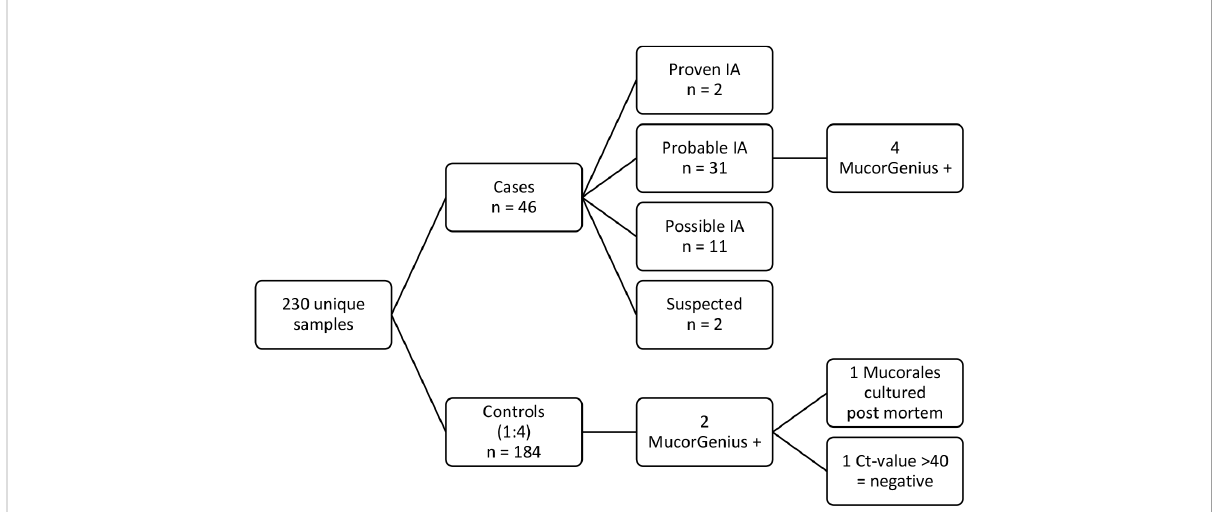
FIGURE 1 Overview of samples tested with Mucorales PCR. Cases were de fi ned based the 2020 EORTC/MSGERC consensus criteria (Donnelly et al., 2020). Controls were patients that underwent a diagnostic workup but never received anti-Aspergillus therapy due to lack of supportive evidence. For cases, the serum sample taken at diagnosis before the start of anti-Aspergillus therapy was used, for controls the serum sample that was drawn on the day that the patient had a clinical event (bronchoscopy or chest